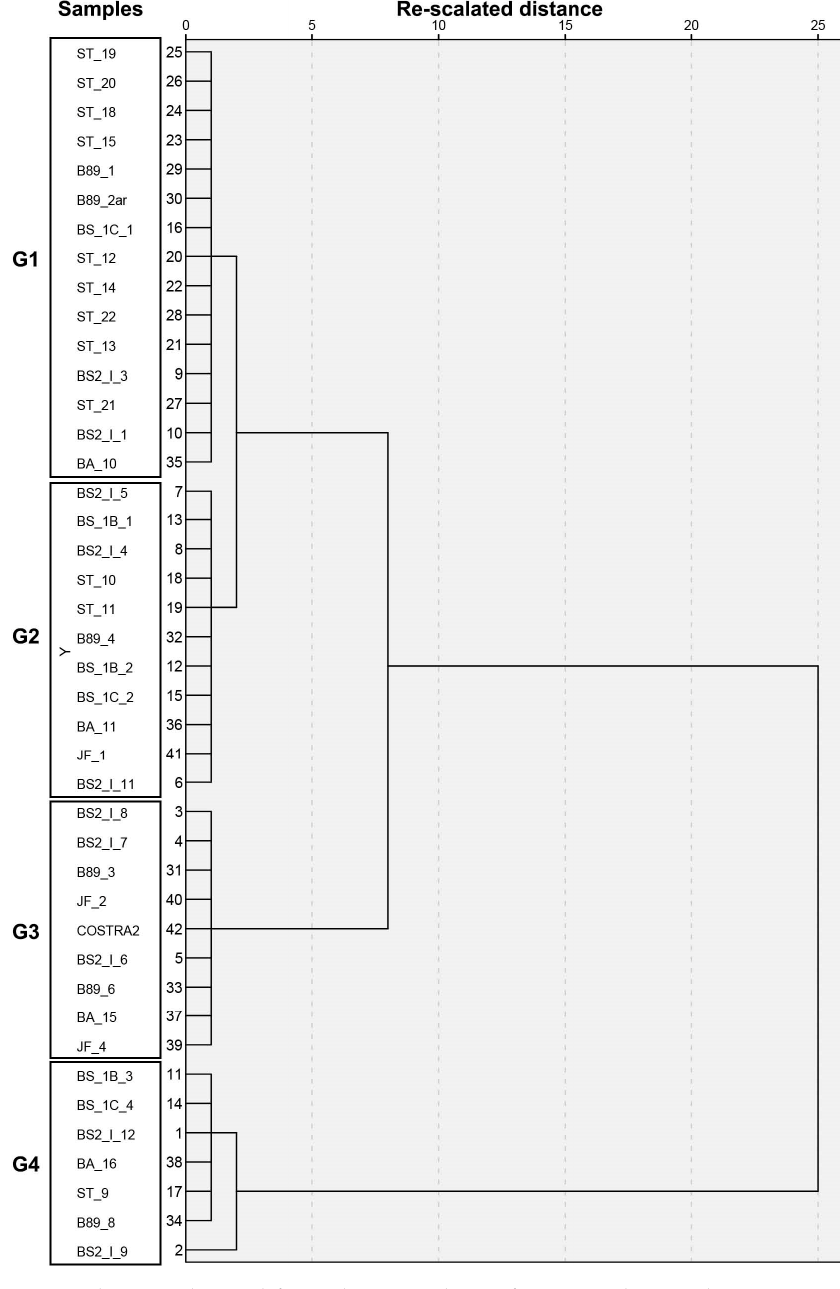
Figure 13. Dendogram obtained from cluster analysis of major and trace elements. Four groups (G1 to G4) were differentiated.